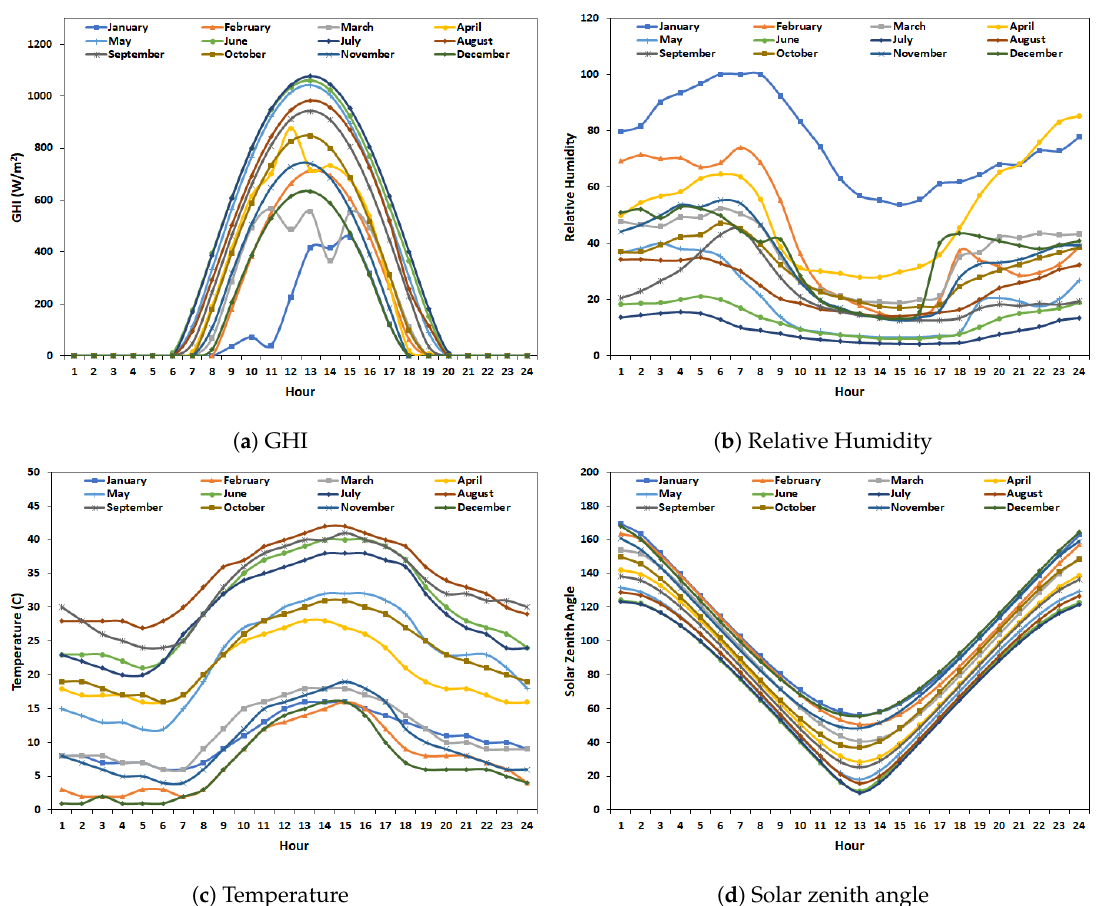
Figure 2. Hourly input data for the first day of each month in